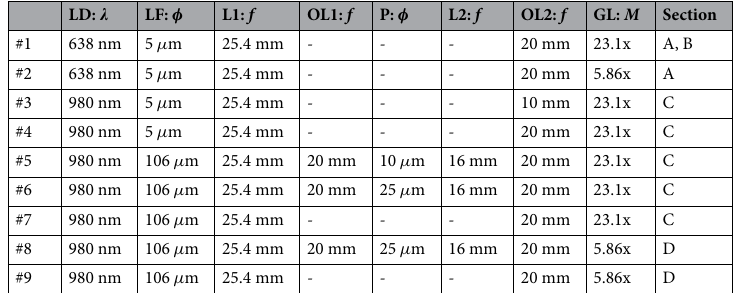
Table 1. Optical equipment properties of each setup: (cid:31) , laser wavelength; φ , mode field diameter and diameters of the fiber and pinhole; f , focal length; M , magnification. Section A, Laser steering under endoscopic observation; B, Laser steering evaluation; C, Light intensity profile evaluation; D, Tissue